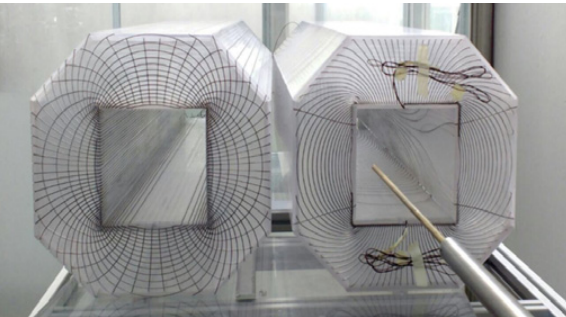
Figure 3. Front view of the input and output coils, each with two layers of acrylic, one for each field component (vertical and transverse). The output coil (left) has two layers of windings: one to produce the transverse decreasing field, which also needs to alternate polarity to produce clockwise or counterclockwise rotations of the neutron spin; and the second to produce a vertical increasing field